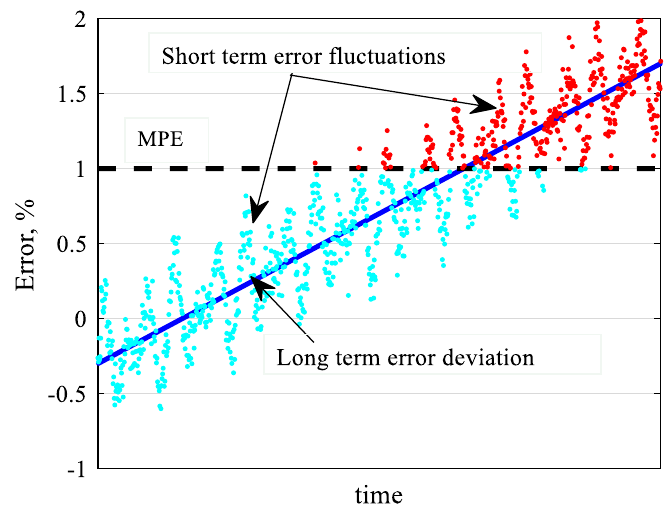
Figure 2. Long term and short term meter error deviation and maximum permissible error (MPE) boundary.